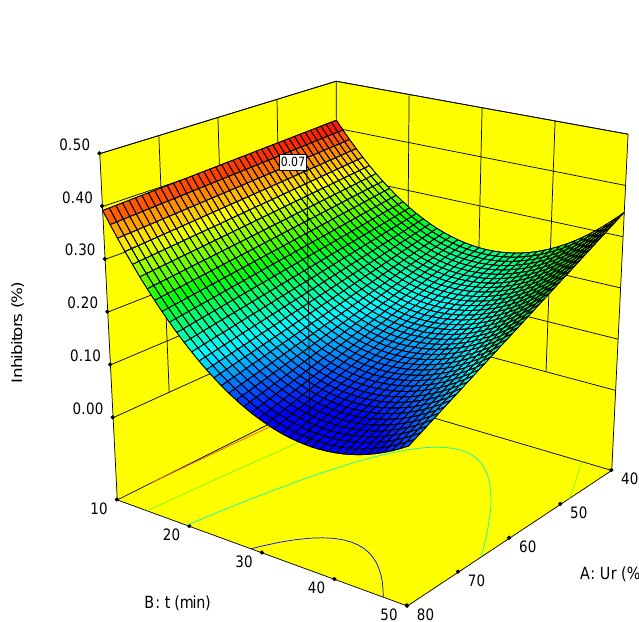
Figure 8. Inhibitors in the pulp after treatment with the pilot vibro-fluidized bed at different treat- ment conditions.